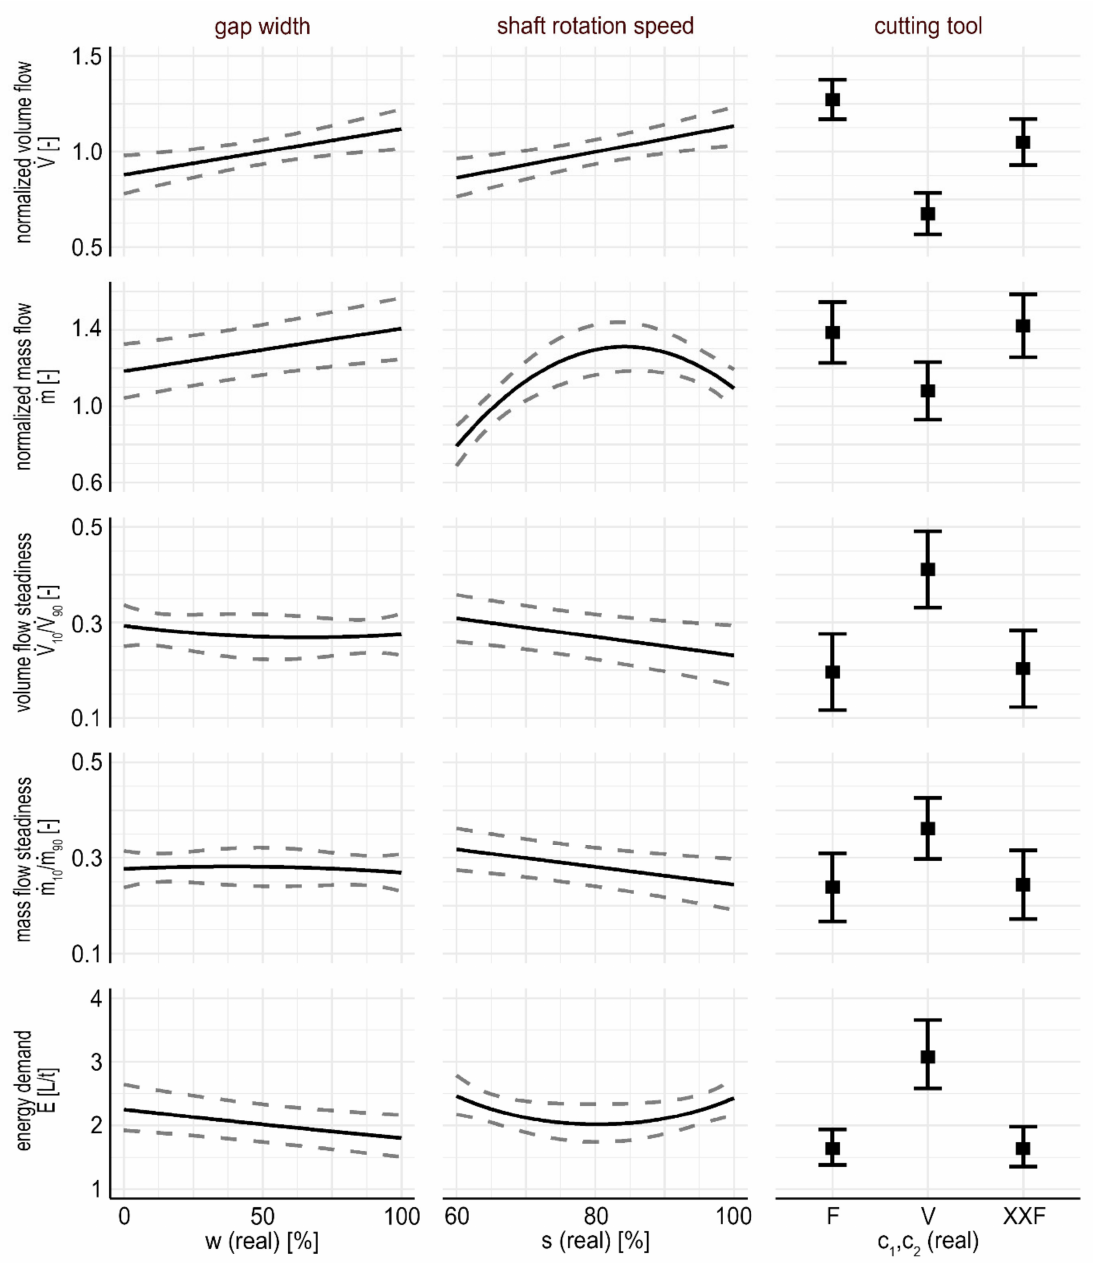
Figure 19. Effect plots with confidence bands for the influence of the gap width, shaft rotation speed, and cutting tool geometry on throughput, throughput steadiness, and specific energy demand, at average settings of the respective other factors